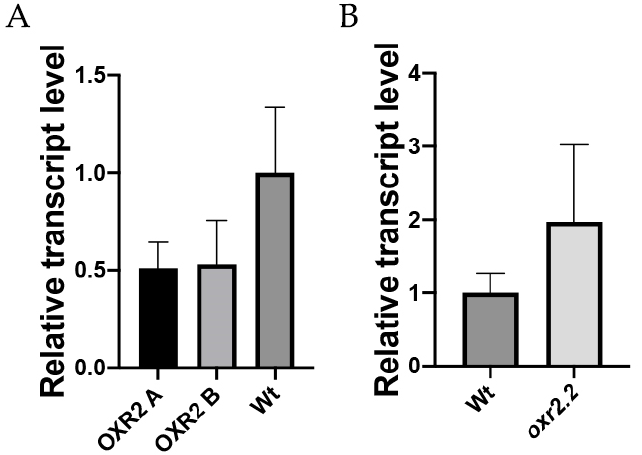
Figure 6. PbBSMT expression normalized to PbActin in roots 20 dai in ( A ) OXR2 A and B overex- pressor lines and ( B ) mutant oxr2 plants compared to wild type. Results are expressed as mean ± SD.